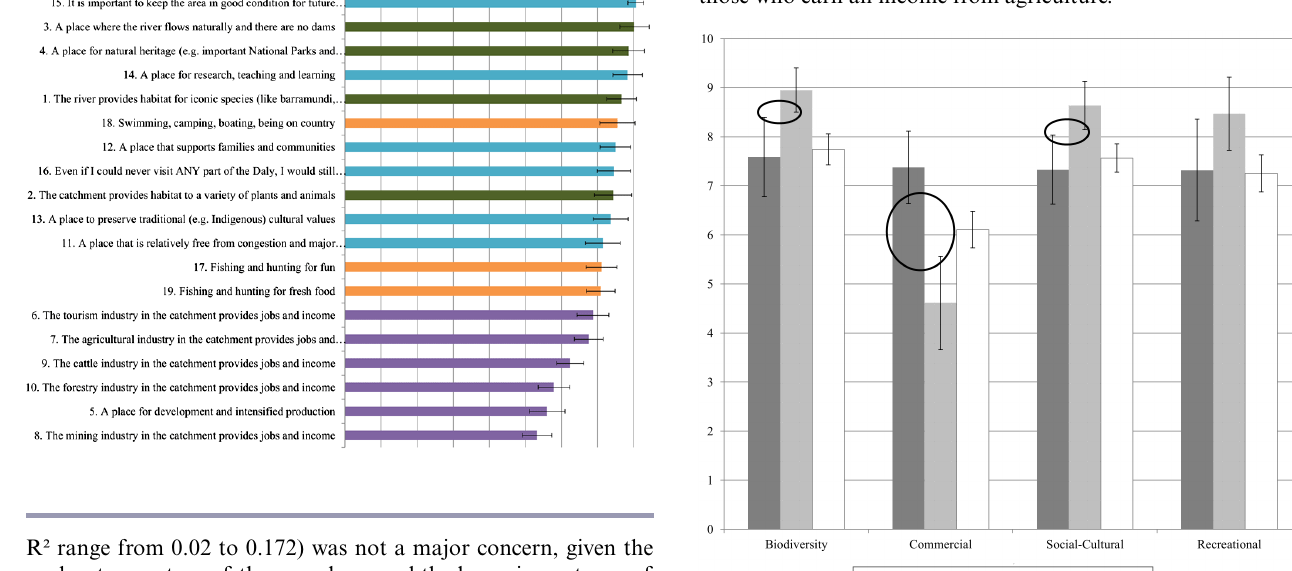
Fig. 4 . Average importance values given to well-being factors, by domain, for three groups of respondents: those earning an income from agriculture, indigenous respondents, and total respondents. Confidence intervals for three of the four domains (circled) do not overlap between indigenous respondents and those who earn an income from